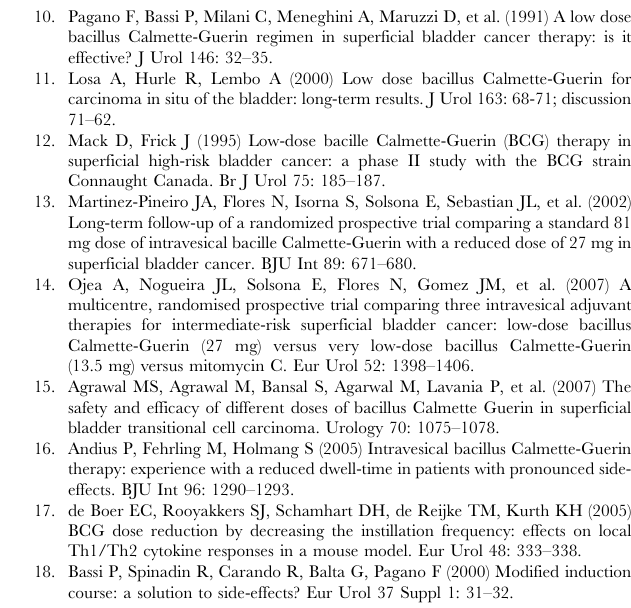
Table S1 State variables of the model along with their biological description. The state variables represent counts of various cell types involved in the interactions between the immune system, tumor cells and BCG. Table S2 Stochastic processes and their corresponding rates. Table S3 Parameters of the model. (TIFF) Text S1 Detailed description and numerical analysis of the stochastic mathematical